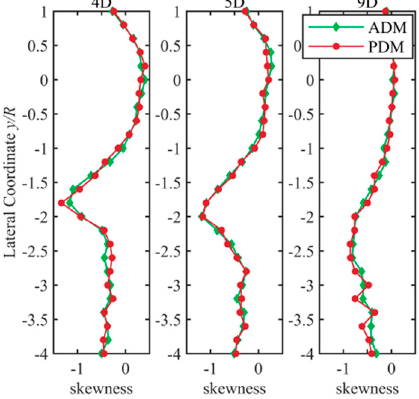
Figure 20. Skewness downstream in the ADM and PDM measured at hub height (UIF conditions).